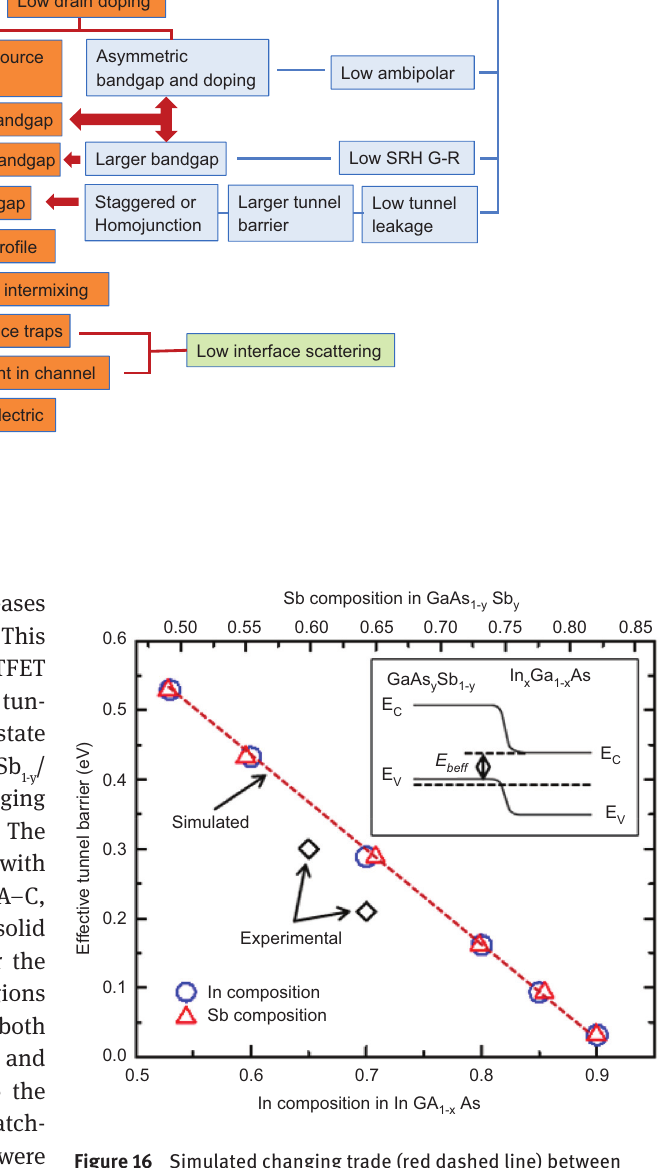
) and In/Sb compositions. beff Sb /In Ga As y 1-y x 1-x is also shown. The effective tun- beff